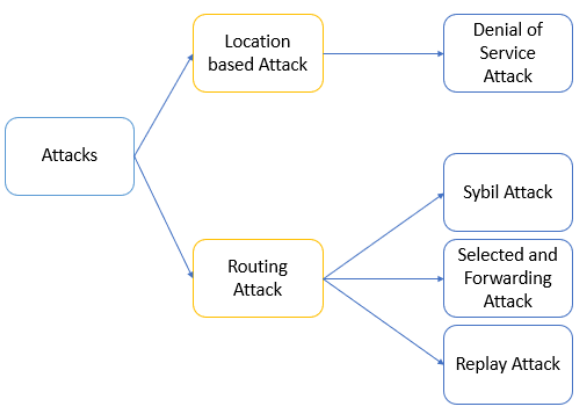
Figure 5:Taxonomy of attacks in Smart Health